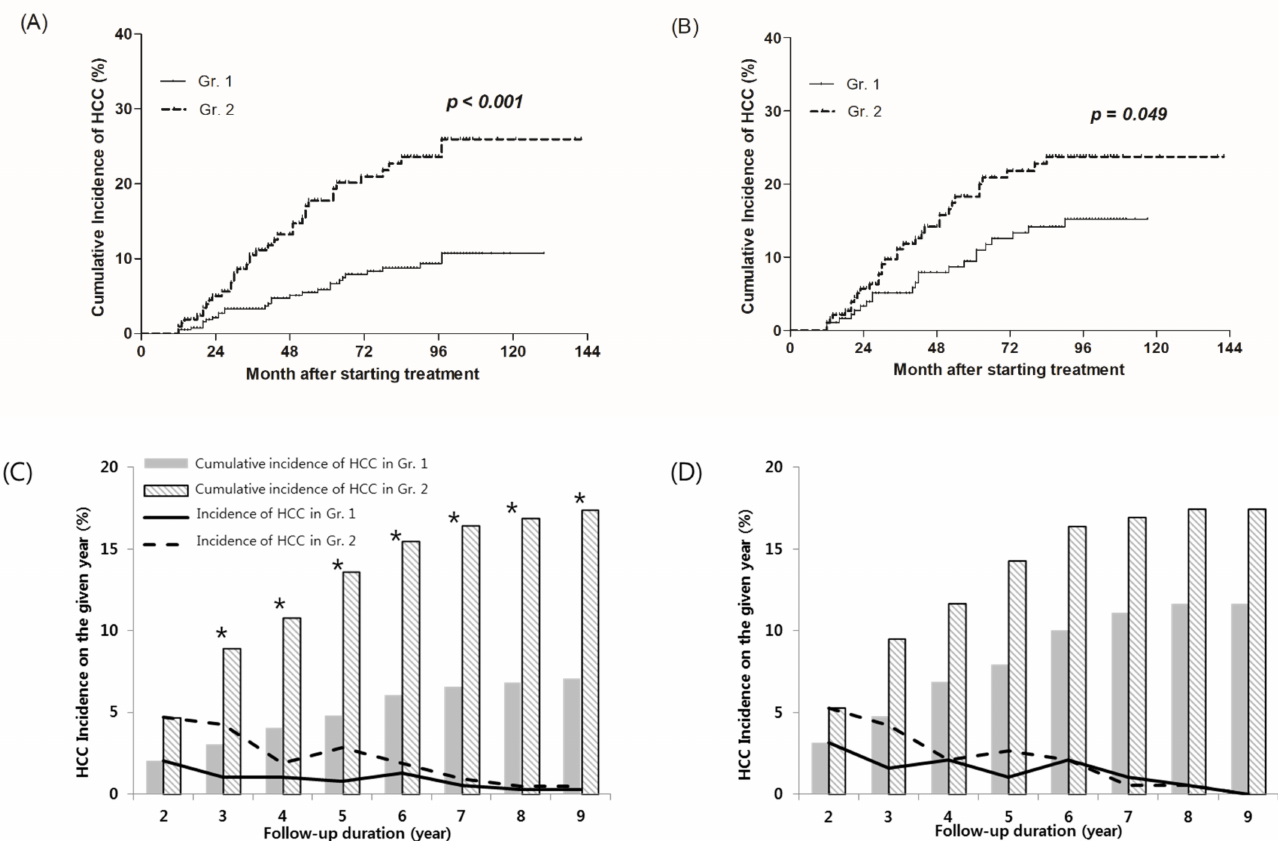
Figure 2. Cumulative incidence of HCC according to early treatment ALT normalization. ( A , C ) A total of 610 patients, and ( B , D ) 378 patients after propensity matching. HCC, hepatocellular carcinoma. * Denote the columns at the time when significant differences were